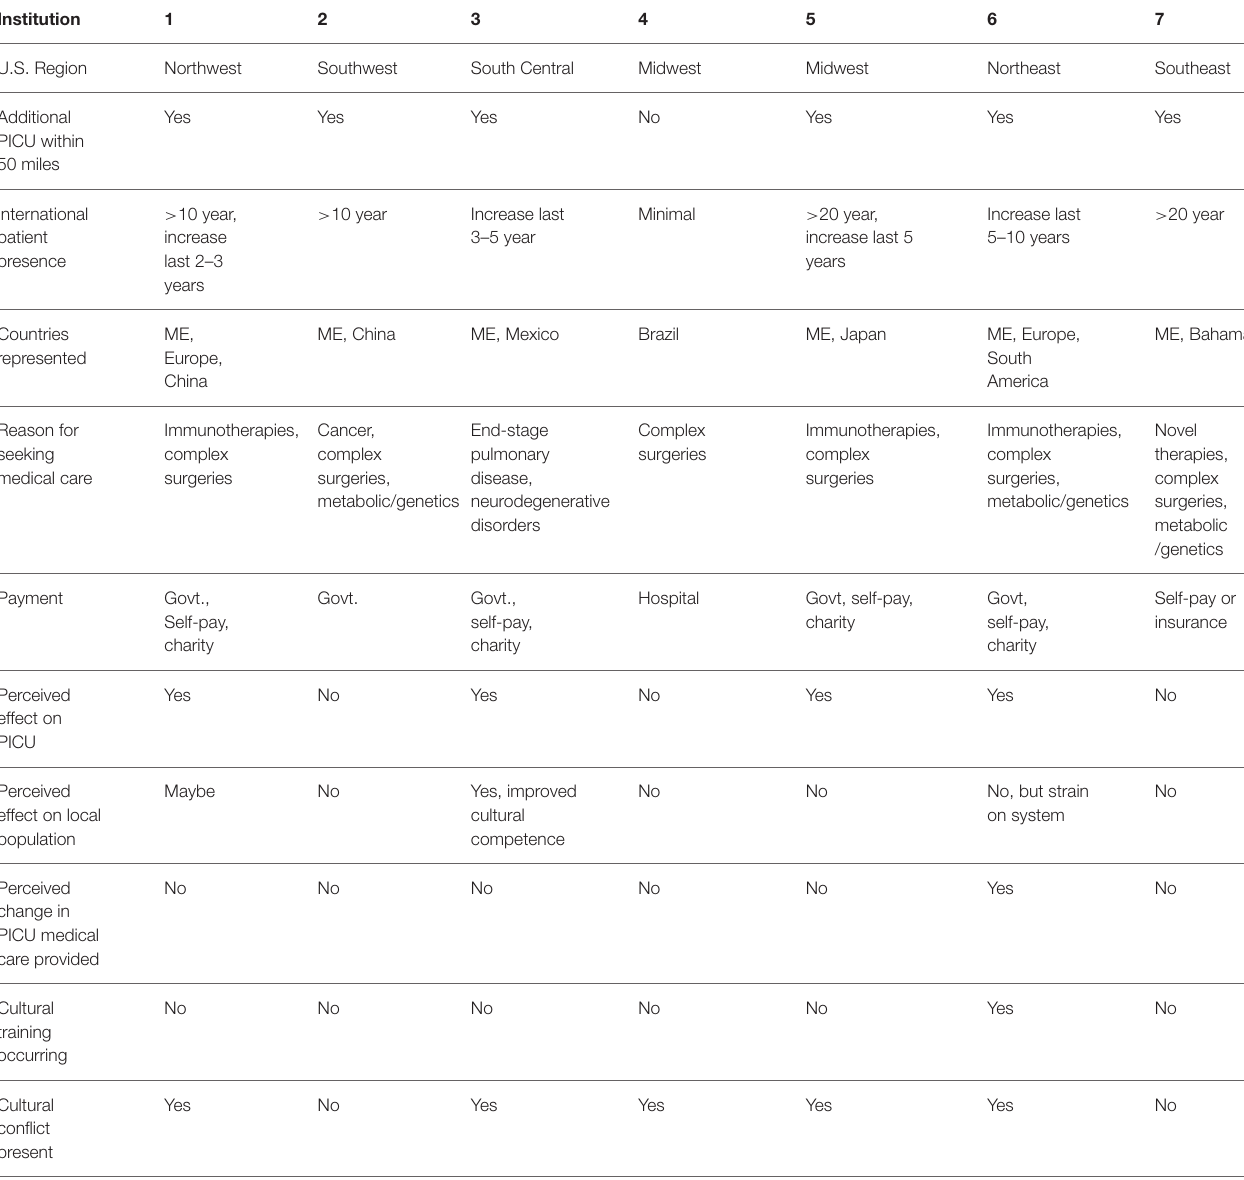
TABLE 1 | PICU demographic information, international patient characteristics and perceived impact by institution.